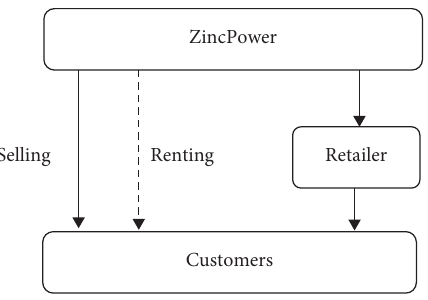
Figure 7: The supply chain